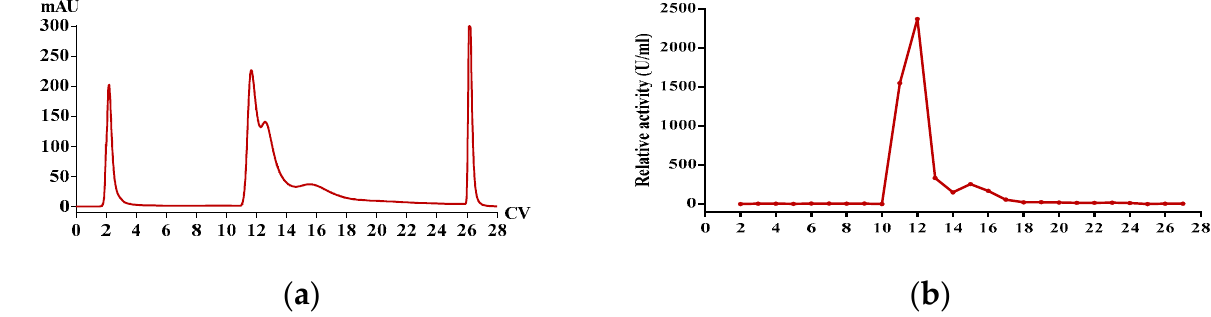
Figure 1. ( a ) HiTrap Q HP chromatogram of P. vulgaris crude extract and ( b ) the fibrogenesis inhibition activity of 27 eluted fractions.